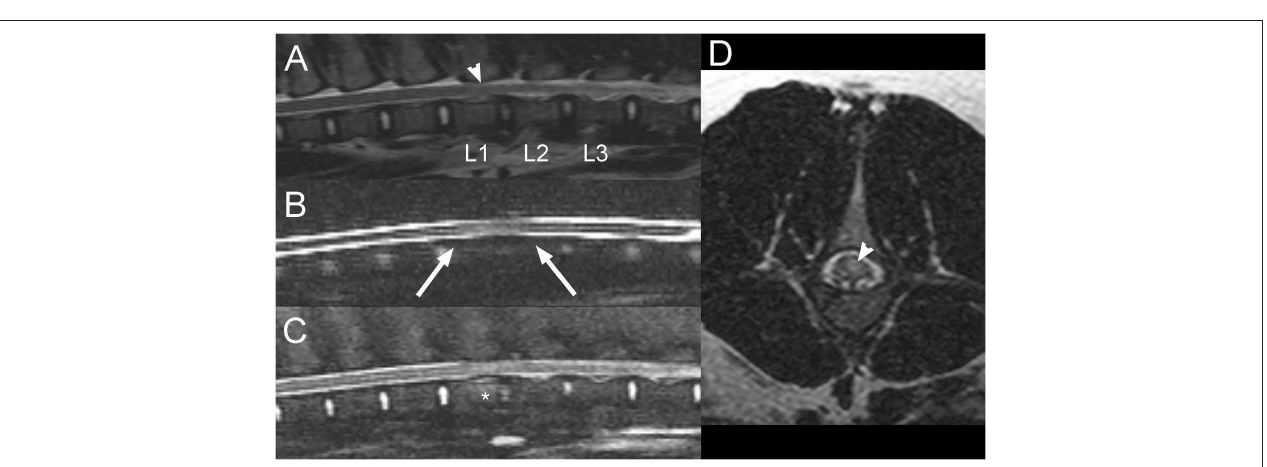
FIGURE 6 | Sagittal T2W (A) , HASTE (B) , STIR (C) , and transverse T2W (D) images of the lumbar vertebral column in a 9-month-old pig with acute L4-S3 myelopathy (Case 6). There is decreased size and T2W signal intensity of the nucleus pulposus of the L1-L2 and to a lesser degree the L2-L3 intervertebral discs (A) . Partial attenuation of the dorsal and ventral CSF signal is noted on sagittal HASTE images with mild dorsal deviation of the ventral CSF column over L1-L2 intervertebral disc space ( B ; arrows). A small amount of extradural material is associated with the ventral aspect of the vertebral canal, but there is no evidence of significant spinal cord compression (A,C) . On STIR images, the caudal half of the L1 vertebral body is mildly hyperintense to the bone, consistent with edema or a bone contusion ( C ; *). There is mild diffuse T2 hyperintensity within the spinal cord at the level of L1-2 disc space, slightly more severe left sided ( A,D ; arrowheads). These findings were considered most consistent with